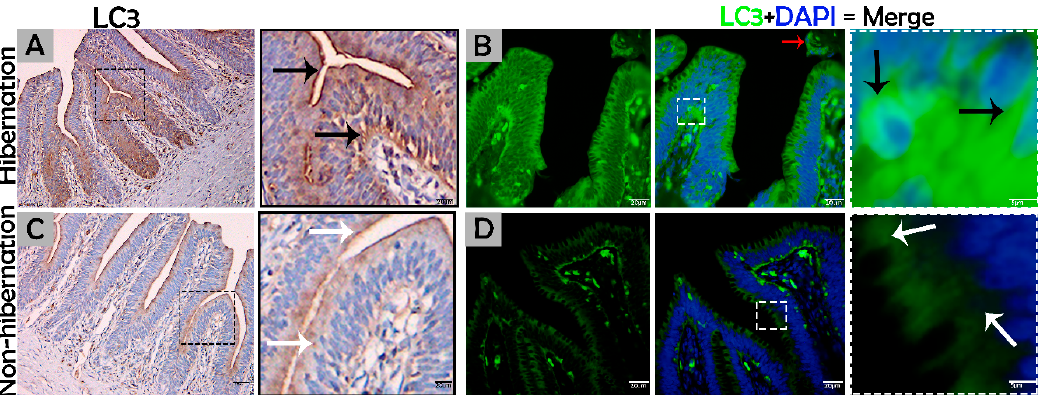
Figure 2. Immunohistochemistry and immunofluorescence staining of LC3 in the mucosal surface of the small intestine of P. sinensis. During hibernation ( A , B ) and nonhibernation ( C , D ), there was a strong, positive expression (black arrow), a strong, positive expression in the lumen of the intestine (red arrow), and weak expression (white expression). Scale bar = 50 µm ( A , C ) and 20 µm ( B , D ).